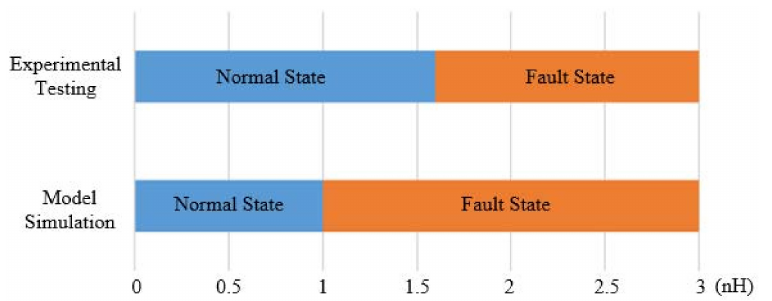
Figure 5. The normal and fault values of the connection resistance of bonding wires in the experi- mental testing and model simulation.